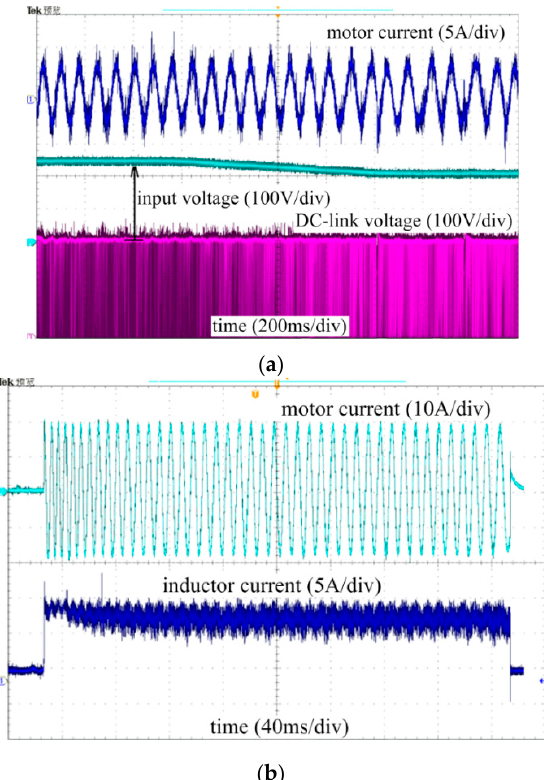
Figure 7. ZSI waveforms with varying working condition ( a ) With varying input voltage; ( b ) With load and unload.